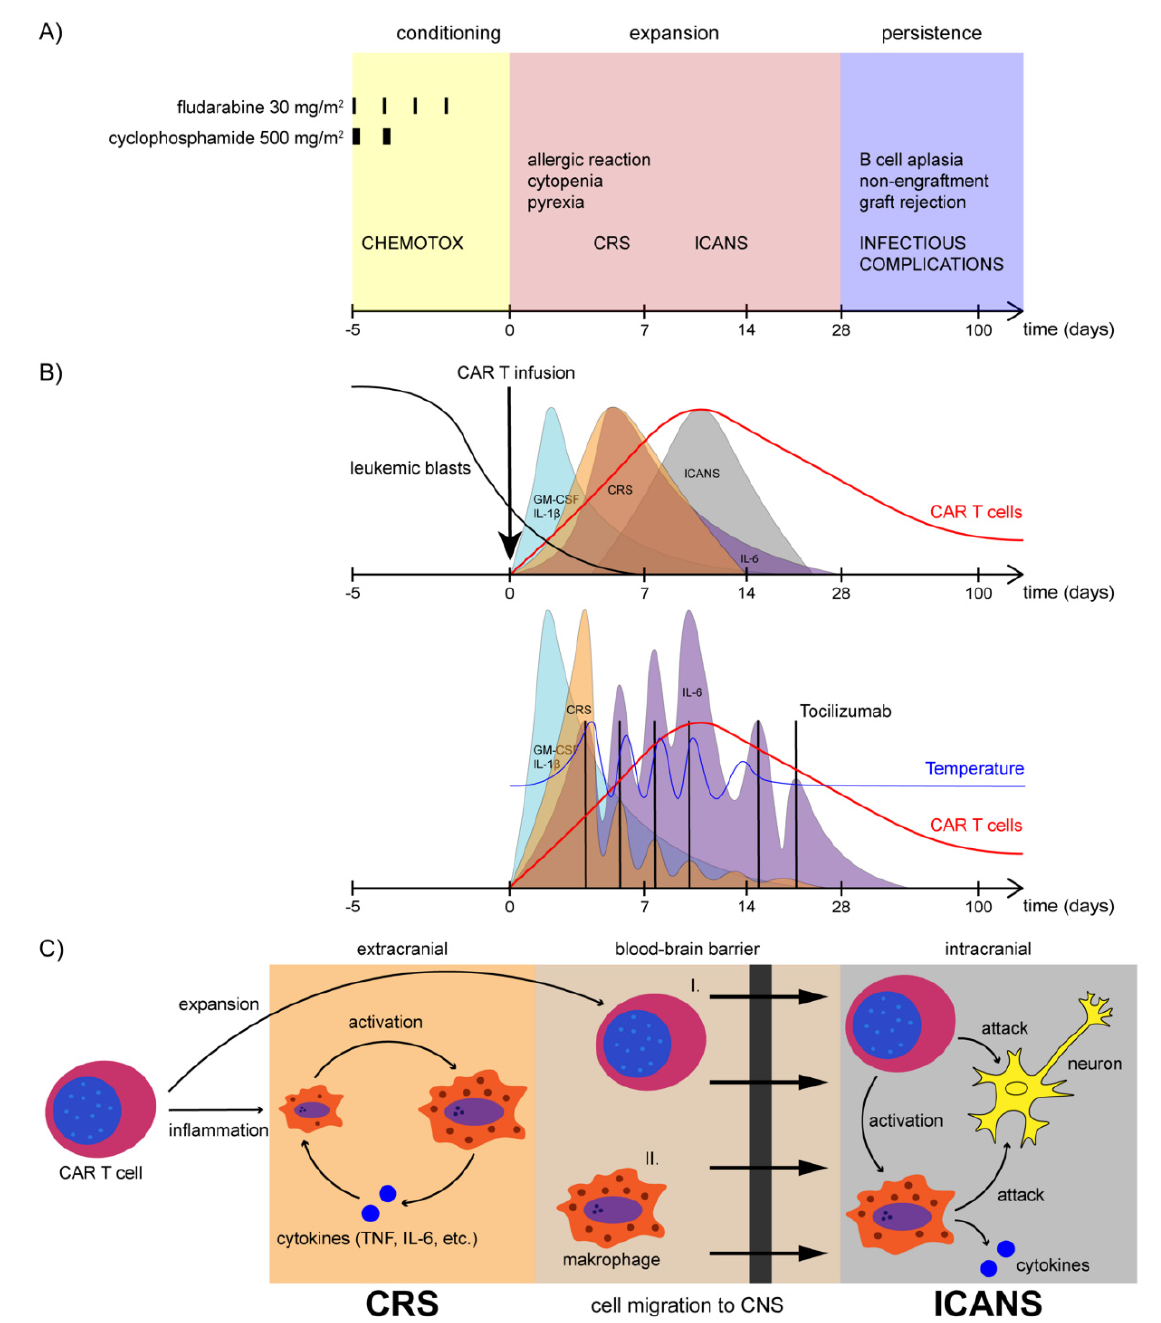
Figure 5. CAR T cell treatment and complications.